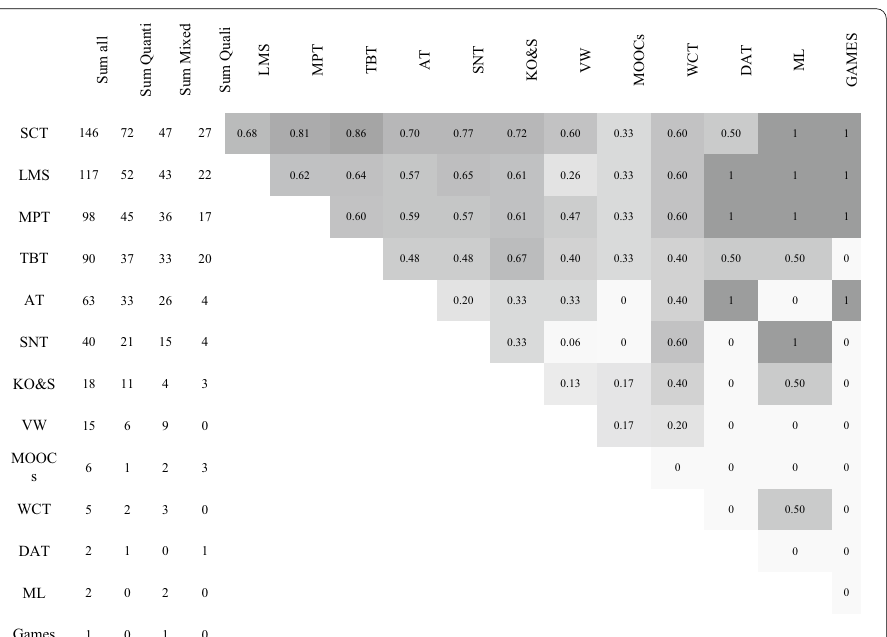
Fig. 6 Co-occurrence of tools across the sample ( n SCT synchronous collaboration tools, LMS = tools, TBT text-based tools, AT = organisation & sharing tools, VW ML mobile =